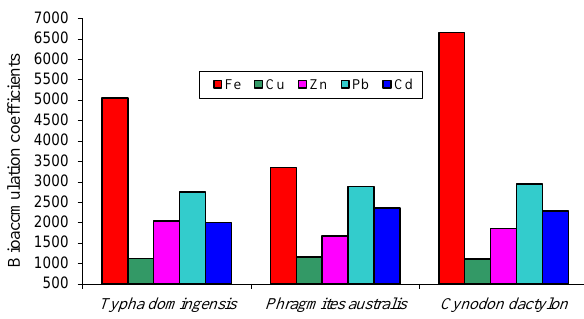
Figure 3. Bioaccumulation coefficients of heavy metals in Typha domingensis , Phragmites australis , and Cynodon dactylon plants grown in Zefta